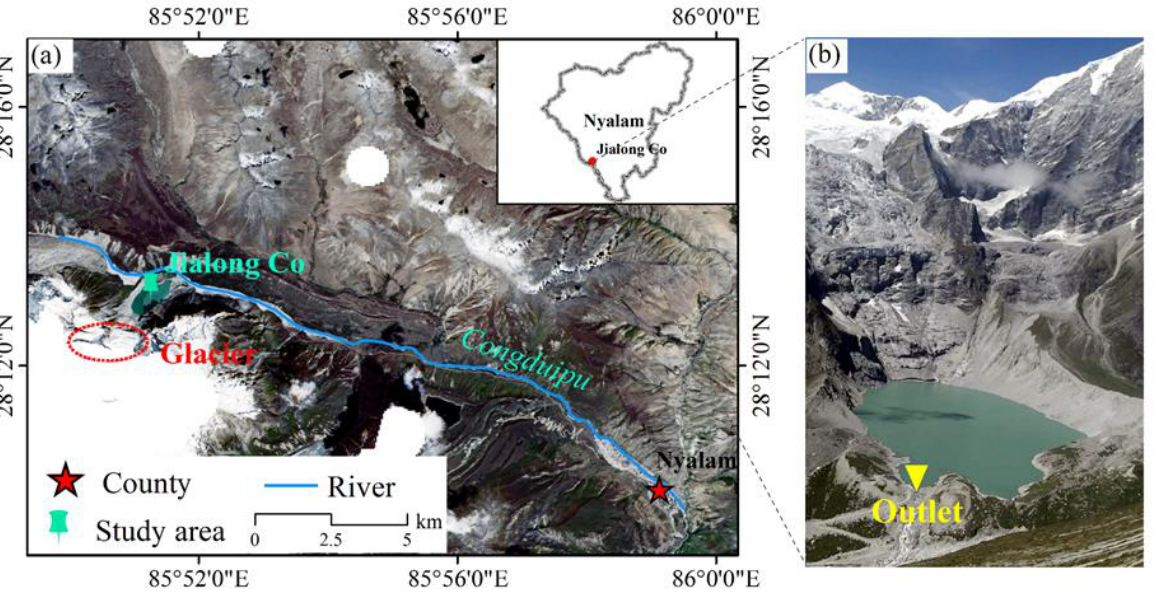
Figure 1. Geographic location of the Jialong Co glacial lake ( a ) (background image: Sentinel-2 MSI image, September 2020). Photos of the glacial lake at Jialong Co ( b ).